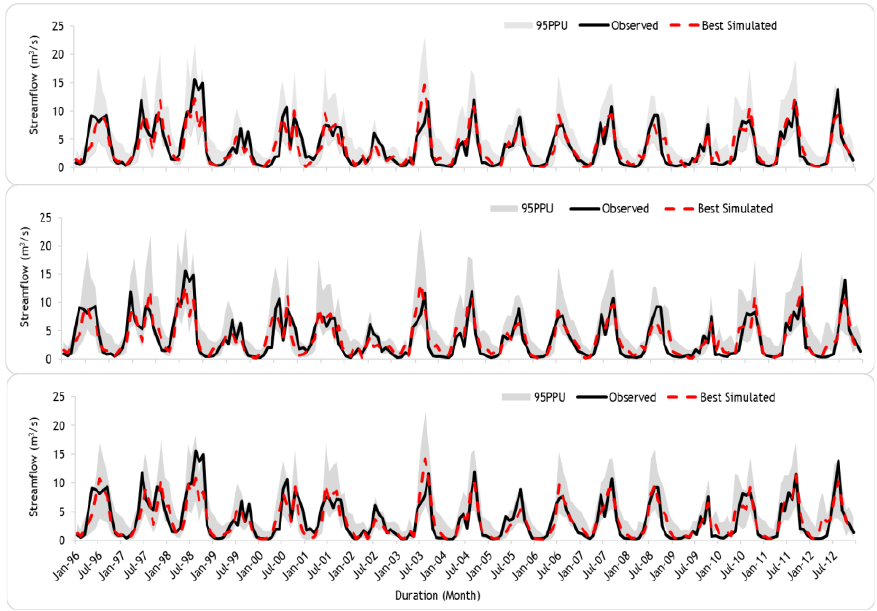
Figure 9. Top-down orientation of observed and best-simulated flows with their 95% confidence level of the subbasin segmentations of 3, 3, and 23, respectively, at the Gecha